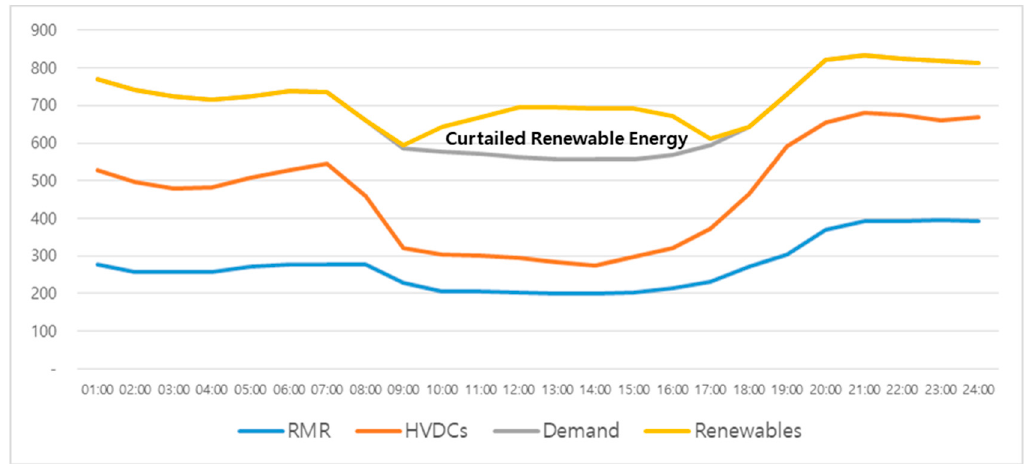
Table 1. Jeju power facilities and renewable energy generation.